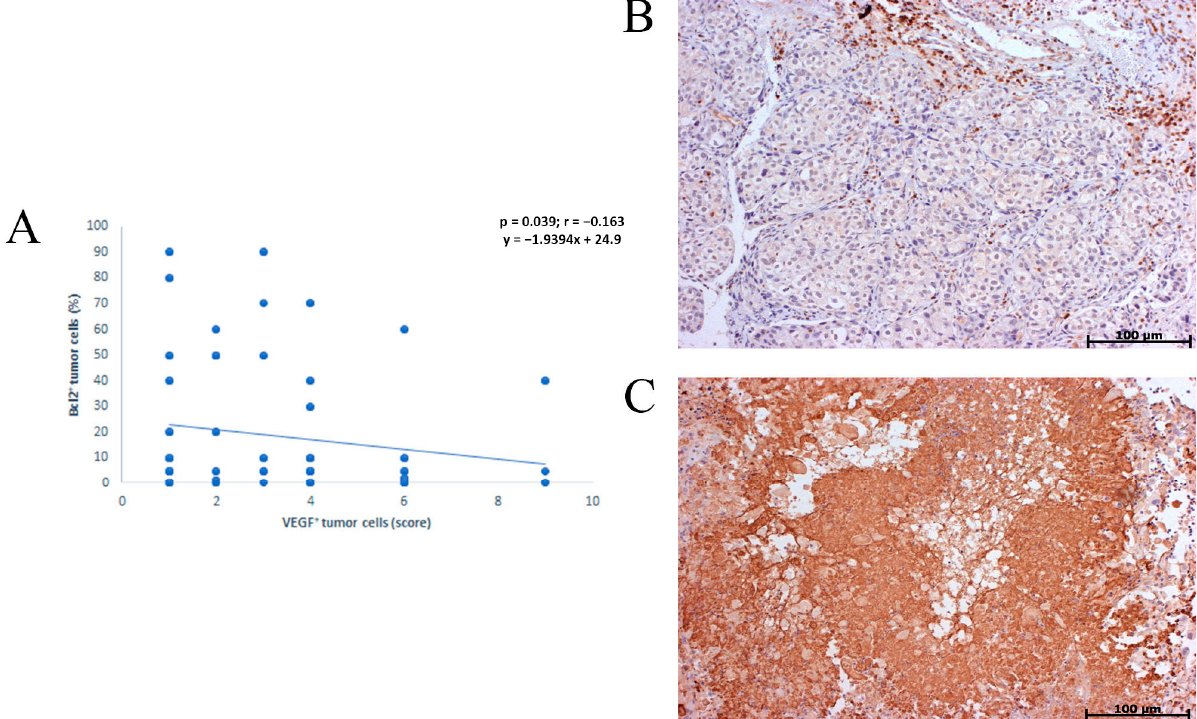
Figure 3. Graphic and histomorphological presentation of inverse Correlation between Bcl-2 and VEGF expression in NSCLC. ( A ) graphic of inverse corelation; ( B , C ) histomorphological presentation.